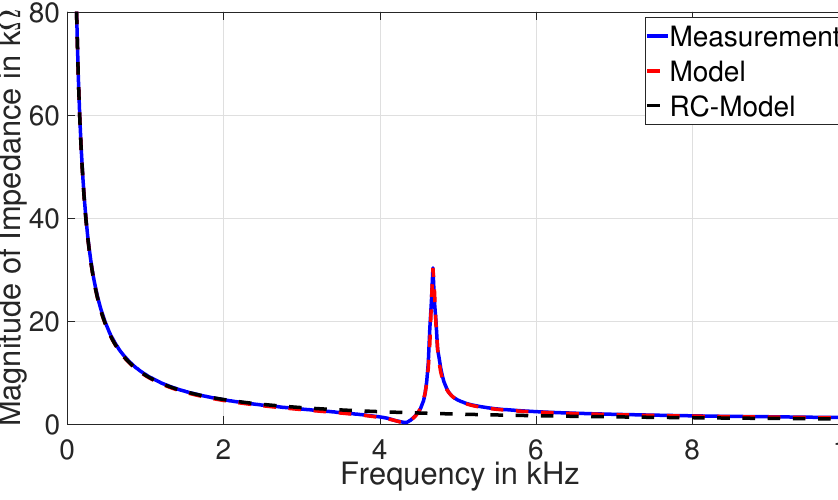
Figure 14. Comparison of magnitude of impedance of